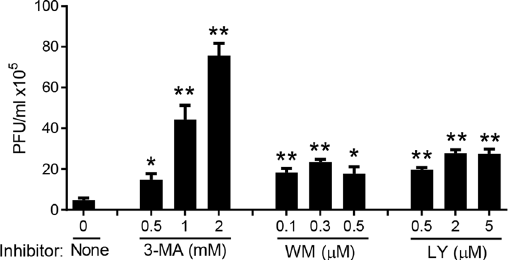
Figure 1. Inhibition of PI3K enhances WNV infection of bone marrow derived macrophages (BMDMs). BMDMs were infected with WNV in the presence of DMSO (None), or various concentrations of 3-methyadenine (3-MA), Wortmannin (WM) and LY294002 (LY) for 24 h. The numbers of viral particles in the cell culture media are expressed as plaque forming units (PFU) per milliliter. * p < 0.05, ** p < 0.001 (two- tailed unpaired Student’s T-test), Bar: the mean of the result + s.e.m. The data shown are representative of 3 independent reproducible